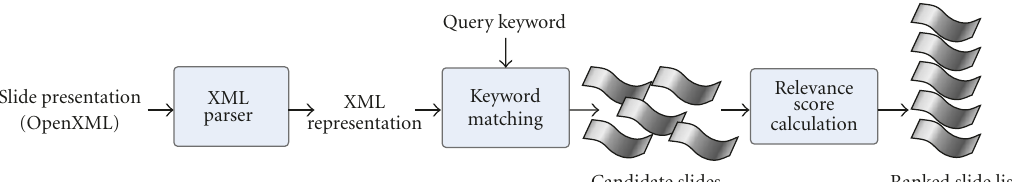
Figure 1: Overview of the proposed system.